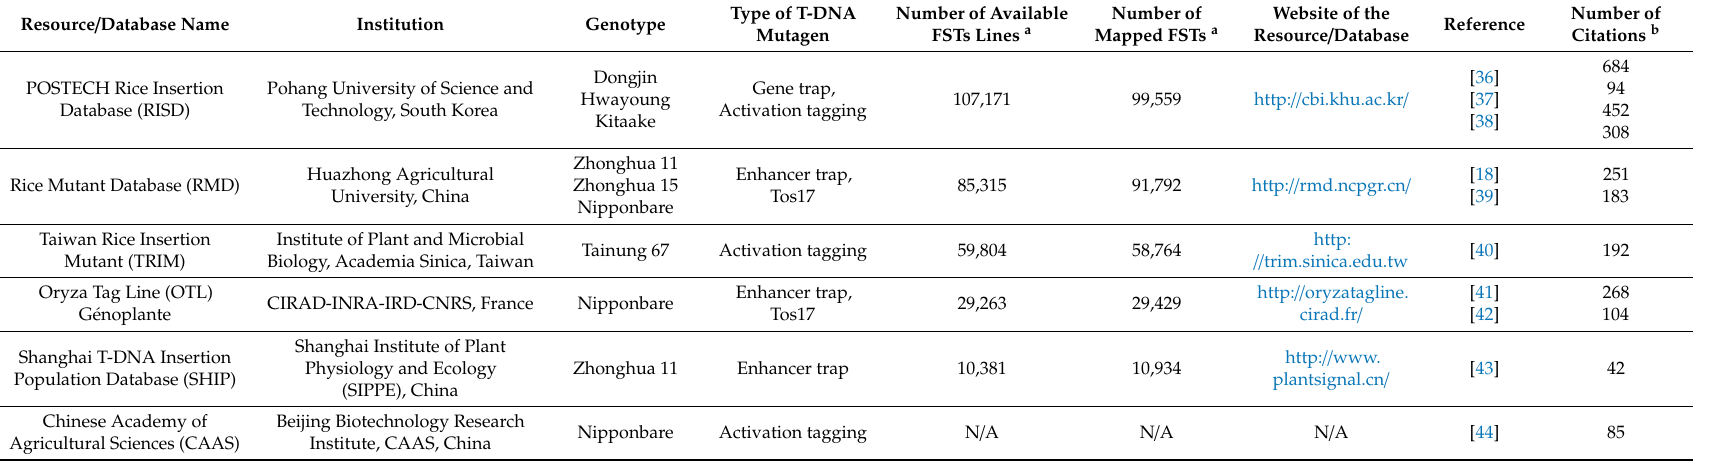
Table 1. T-DNA mutant resources in